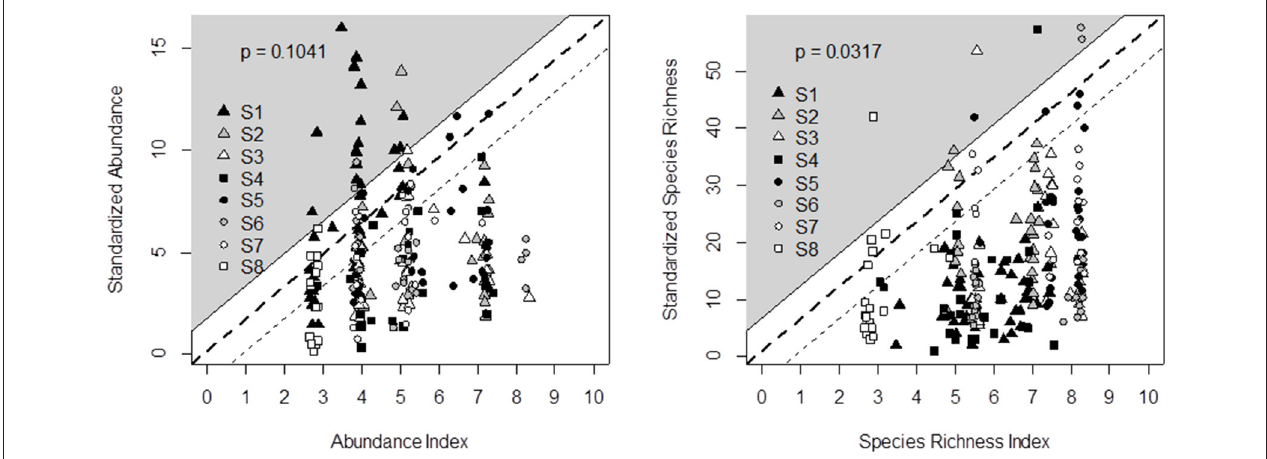
FIGURE 2 | Comparison of decision tree outputs (X-axis) and field data recorded in eight experimental surveys (Y-axis) across Germany (S1, S8), Italy (S2), France (S3, S5, S6, S7), and Switzerland (S4) for butterfly abundance (left) and species richness (right). Percentage of points in the gray area (i.e., outside the output validation triangle) enables defining the probability of rejecting indicator validation ( p -value). Since data covered a wide range of temperate grassland conditions, we defined the triangle slope by matching the minimum observed value to an indicator value of 0 and the maximum value to 10. One index point was added to this slope line as an envelope of acceptable prediction